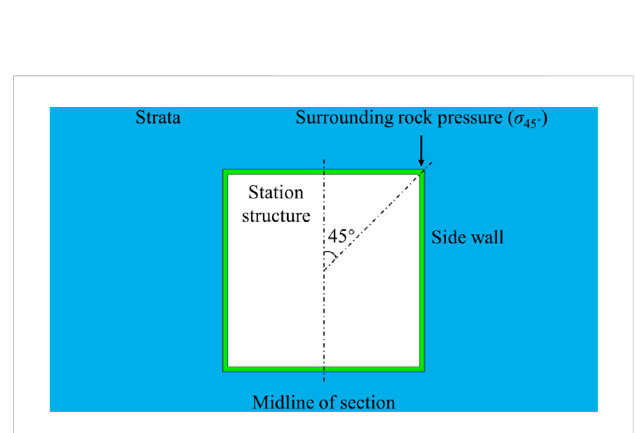
FIGURE 17 Schematic diagram of surrounding rock pressure on the side